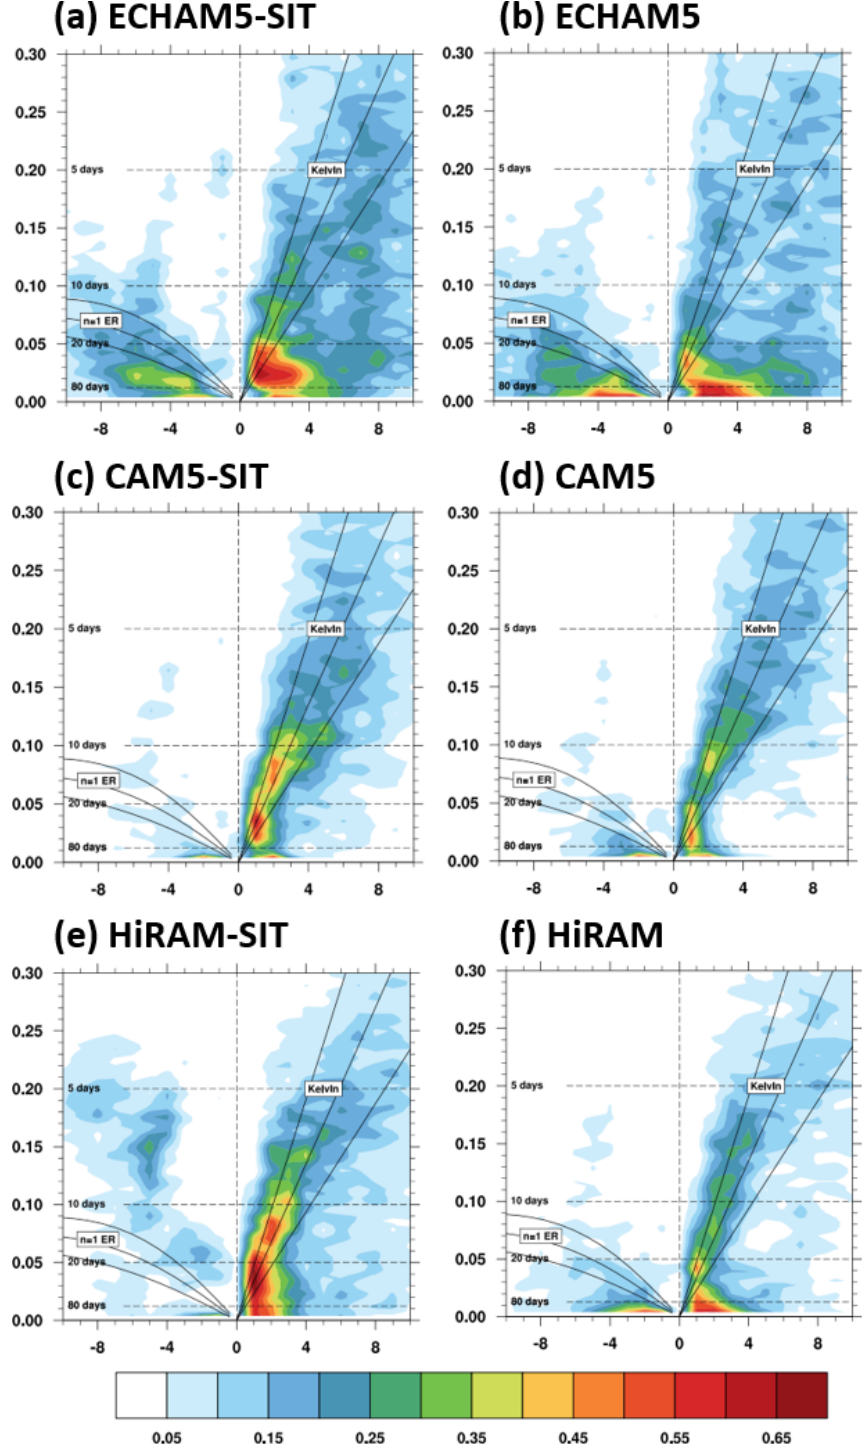
Figure 5. Symmetric wavenumber–frequency spectra of 850hPa zonal wind averaged over 10 ◦ N–10 ◦ S using the (a, c, e) coupled and (b, d, f) uncoupled AGCMs (in m 2 s − 2